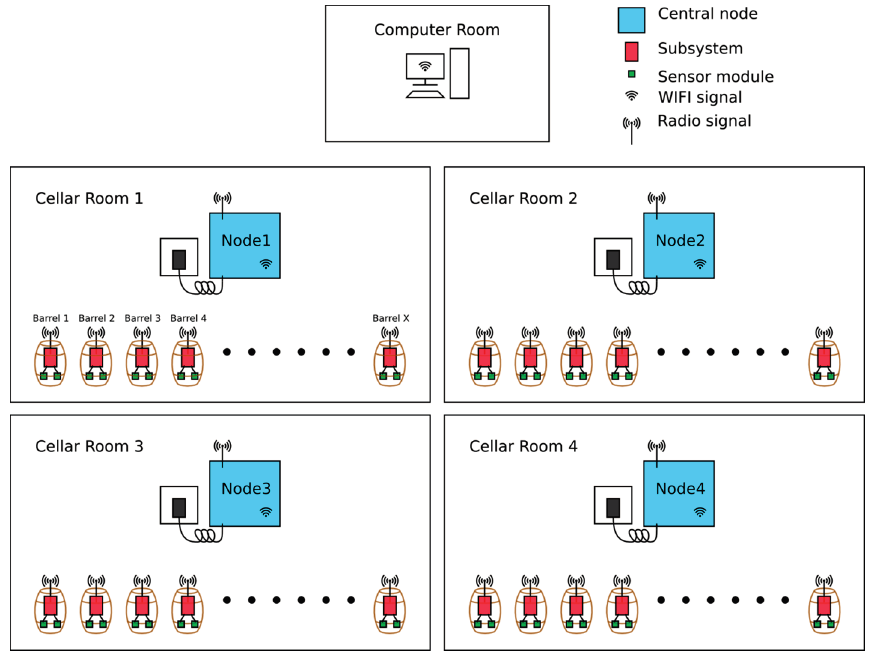
Figure 1. The schematics of the distributed wine monitor